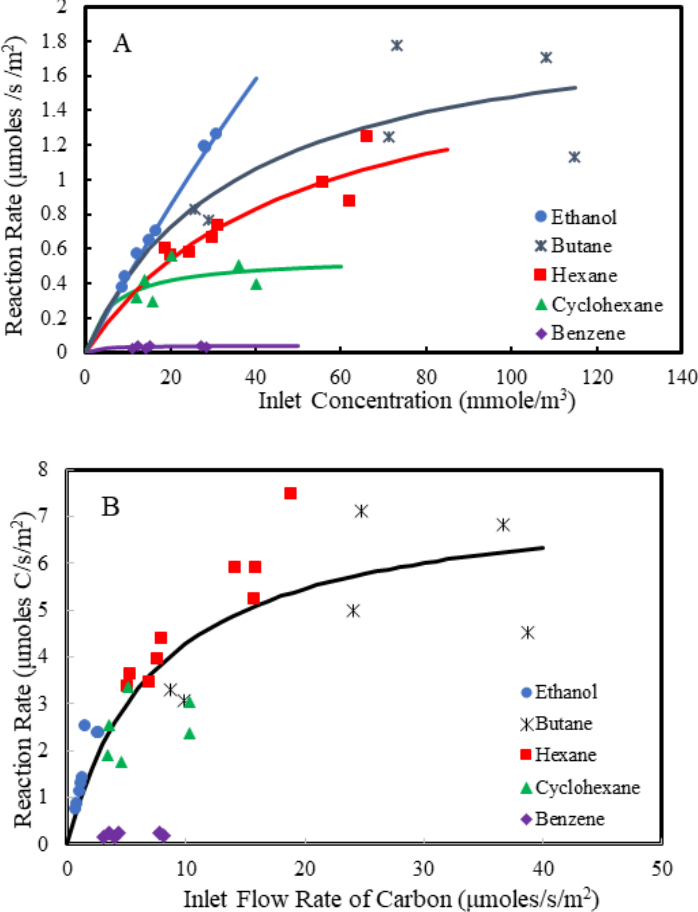
Figure 2. Summary of photocatalytic oxidation rates observed for selected representative fuel vapors. The reactor temperature for all trials was approximately 32 ◦ C. ( A ) reaction rate ( µ moles/s/m 2 ) vs. concentration (mmoles/m 3 ). ( B ) reaction rate ( µ moles carbon/s/m 2 ) vs. flow rate of carbon into the reactor ( µ moles/s/m 2 ). The reaction rates were normalized to illuminated surface area. mmoles = millimoles. µ moles =